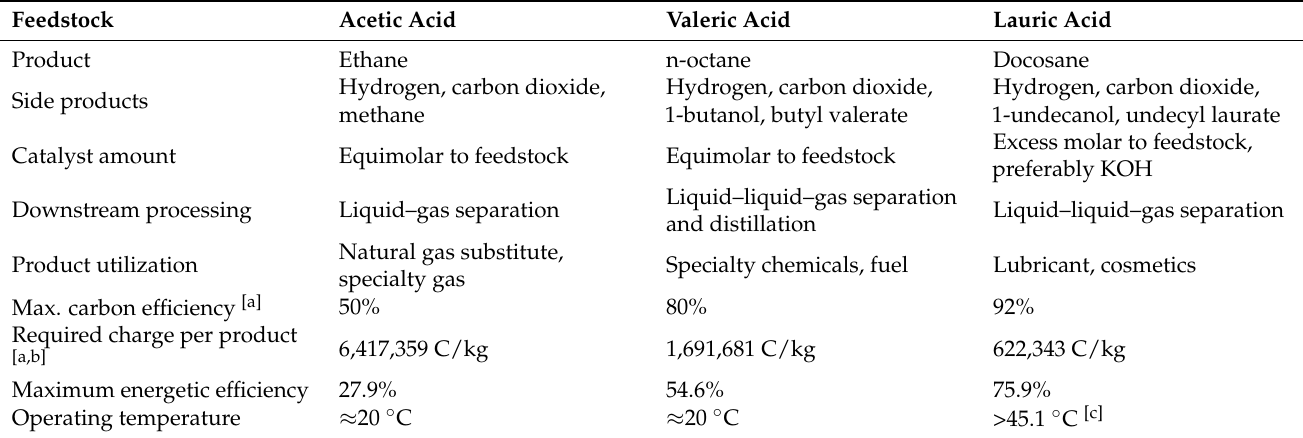
Table 4. Properties of the Kolbe processes based on three different linear saturated